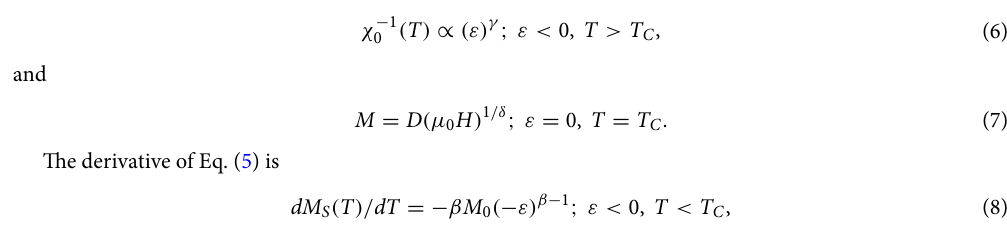
where M 0 , and D are critical amplitudes. The critical exponent β can be obtained by fitting Eq. (5) with M-T plot (Fig. 5b) at zero field or very weak applied magnetic field. But, due to the existence of finite magnetic moment after transition, fitting of M-T data with Eq. (5) becomes difficult. Hence, one has to find out the value of β by fitting the derivative of M-T, which varies with T β − 1 below T C . The fitting of the M-T derivative with Eq. (8) (inset of Fig. 5b) has yielded β = 0.155 . The value of critical exponent δ is determined by fitting the log of Eq. (7) i.e. straight line with log – log plot of M-H at T C . This results δ = 5.490 for M-H at T C 1 (inset of Fig. 5c). Using Widom scaling law γ/β + 1 = δ for β = 0.155 and δ = 5.490 , the value of γ = 0.690 is obtained. Universally, the critical exponents β and γ should follow the Arrott-Noakes equation of state 86